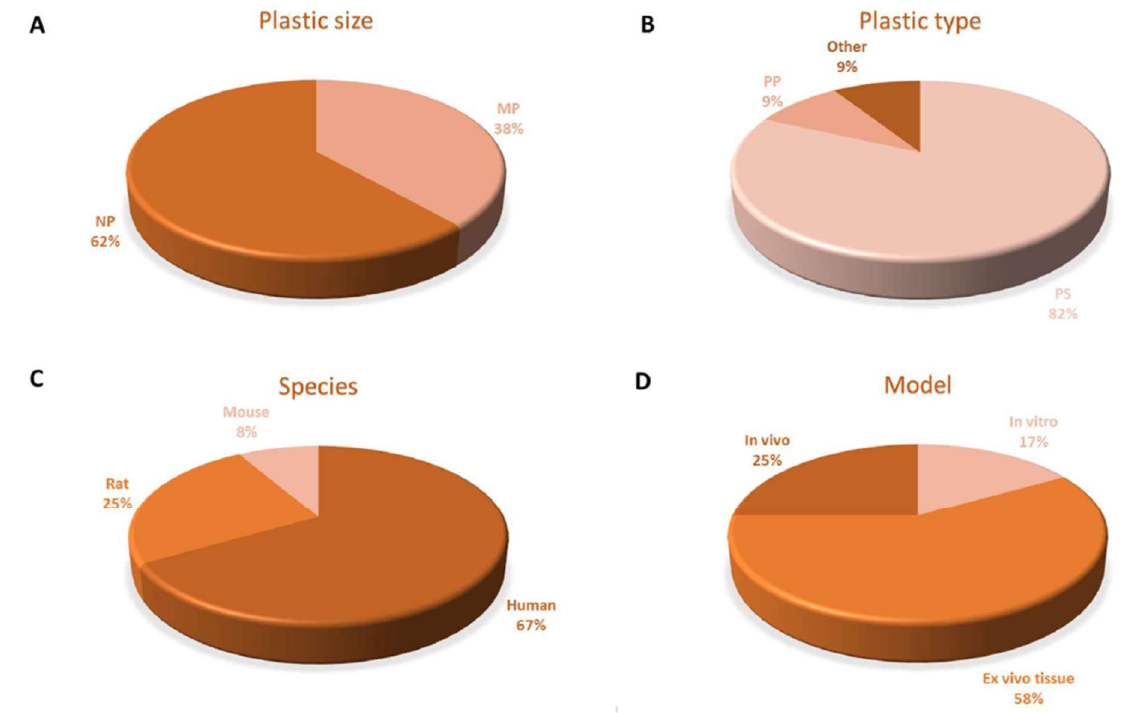
Figure 4. Charts describing the state-of-the-art of MPs/NPs on cardiovascular system in mammals. ( A ) Plastic particles size used in the studies here reported. ( B ) Types of plastics considered. ( C ) Species described for MP-NP effects and ( D ) experimental models used for investigation.